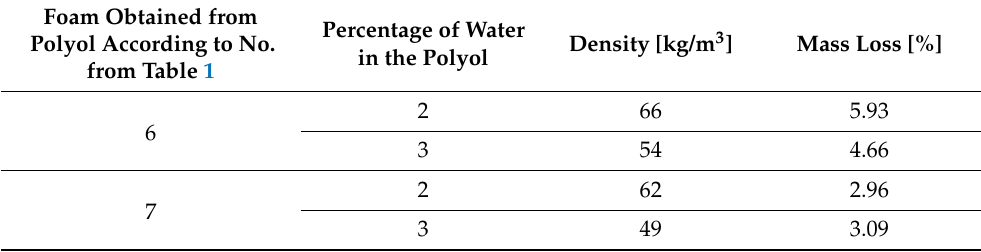
Table 3. Initial thermal resistance test of polyurethane foams at 150 ◦ C after heating 24 h. Foam Obtained from Percentage of Water Polyol According to No. Density [kg/m 3 in the Polyol from Table 1